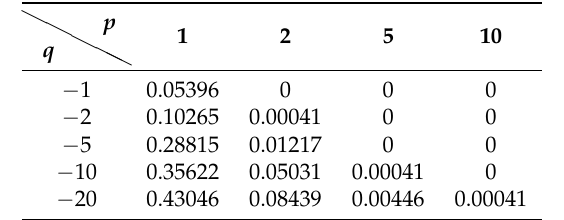
Table 3. Triangle inequality violations, in percentage, for several values of p and q : Here, we randomly chose 80 sets, each one containing 2 points in [ 0,10 ] 2 , and verified the triangle inequality for all possible set permutations (that is, 492,960).